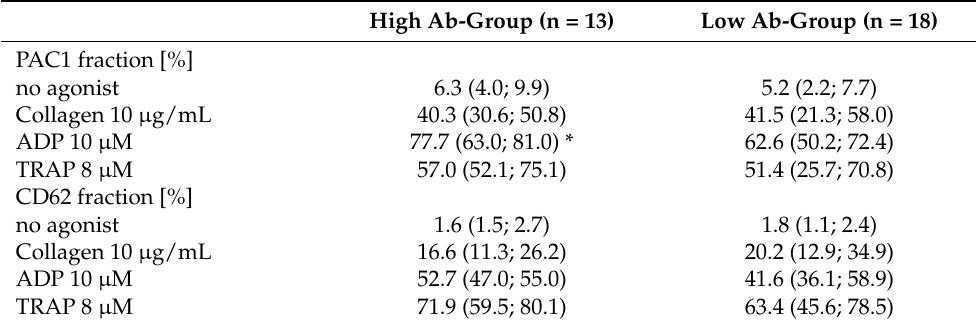
Table 2. Fractions of positive platelets with CD62 exposure and PAC1 bound to activated fibrinogen receptor (GPIIbIIIa) after induction with agonists at high concentration in High and Low Ab-group. High Ab-Group (n =